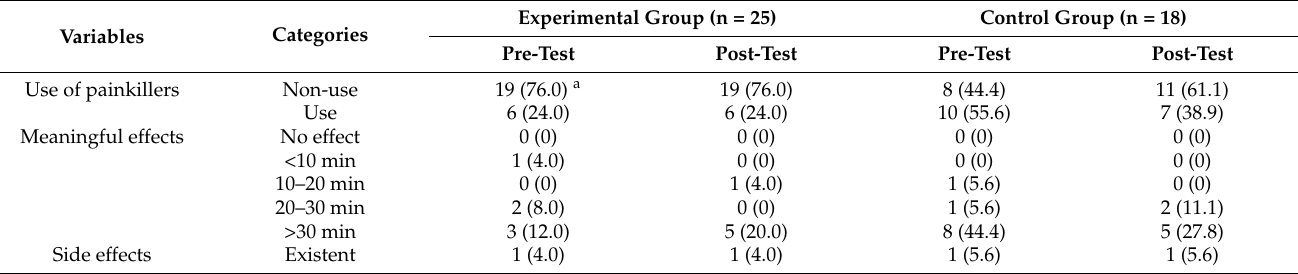
Table 4. Use and effects of